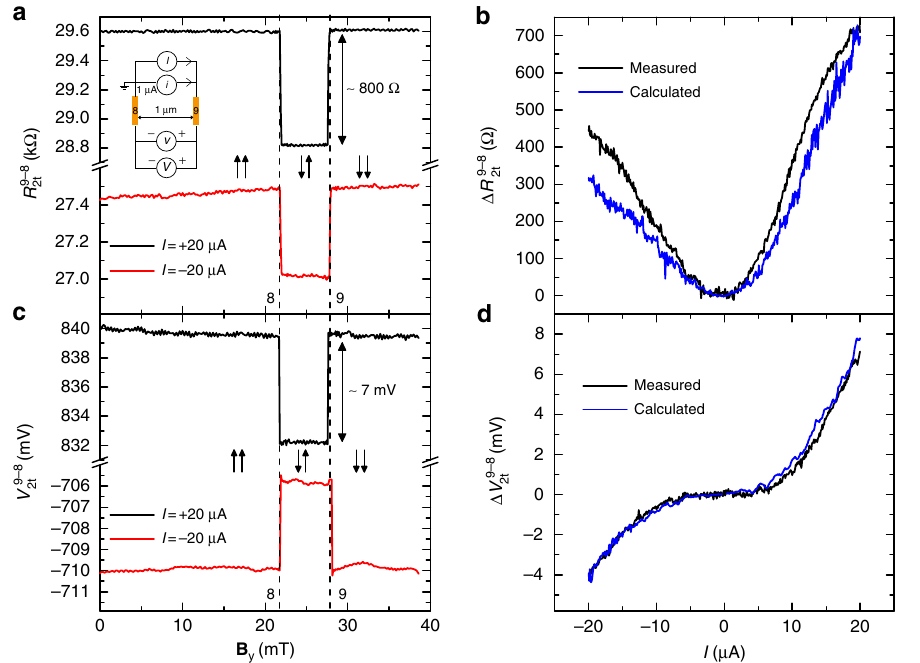
Fig. 5 Large inverted two-terminal spin-valve effect at room temperature. a Two-terminal differential spin-valve signal R 2t ( = v / i ) and c two-terminal DC spin-valve signal V 2t , as a function of B y at two different DC current bias values. The inset in a illustrates the two-terminal spin-valve measurement con fi guration. The arrows ↑↑ ( ↓↑ ) represent the parallel (anti-parallel) orientation of the magnetization of contacts 8 and 9, respectively, from left to right . The vertical dashed lines represent the coercive fi elds of contacts 8 and 9. b Two-terminal differential spin signal Δ R 2t ( I ), and d two-terminal DC spin signal Δ V 2t ( I ), as a function of the DC current bias I . The calculated two-terminal spin signals from the individual spin-injection and detection polarizations of contacts 8 and 9 are also shown in b and d